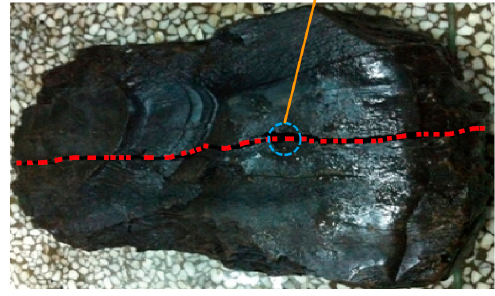
Figure 12. The oil shale sample is broken in the parallel bedding direction.